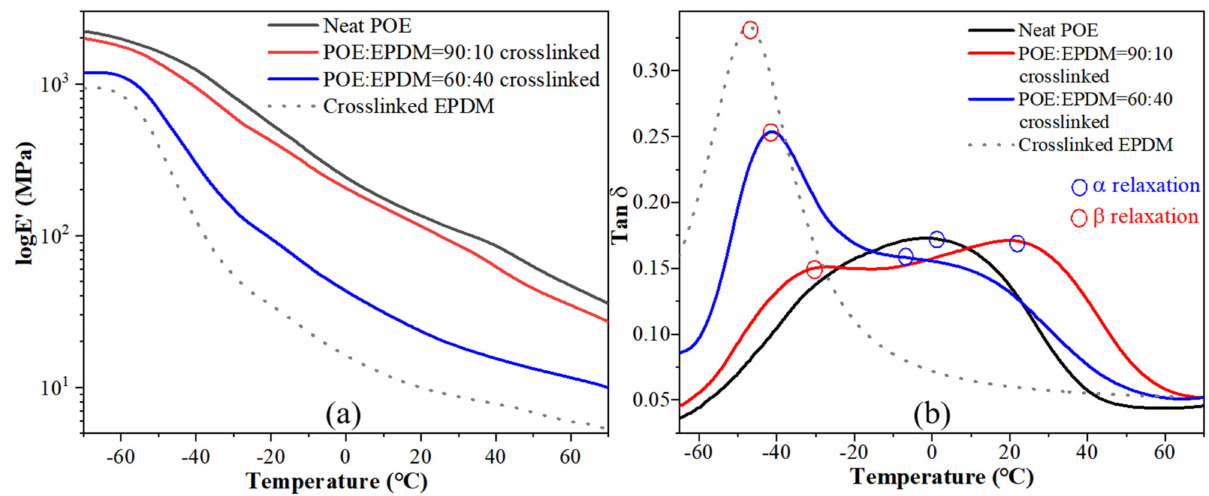
Figure 7. Storage modulus ( a ) and tan δ ( b ) of neat POE and dynamic crosslinked POE/EPDM